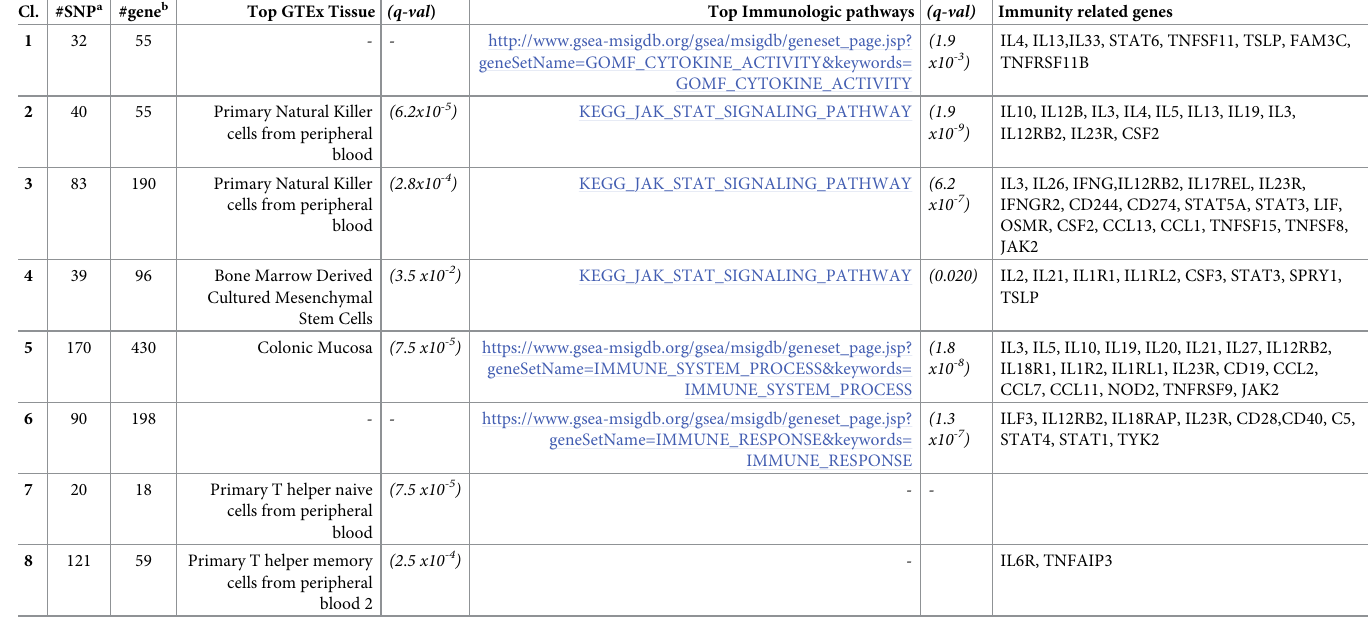
Cluters (Cl.) not mapping to neither tissues nor pathways are indicated by a “-” sign. All reported p-value are FDR corrected. a Count includes only the most associated SNP per region. b Count of genes mapped to